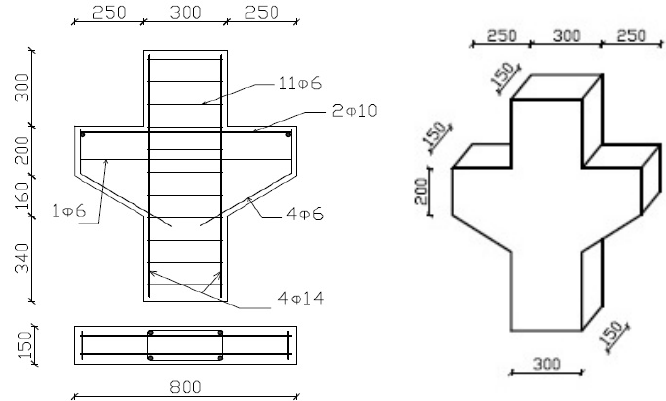
Figure 1: Details of corbel geometry and steel